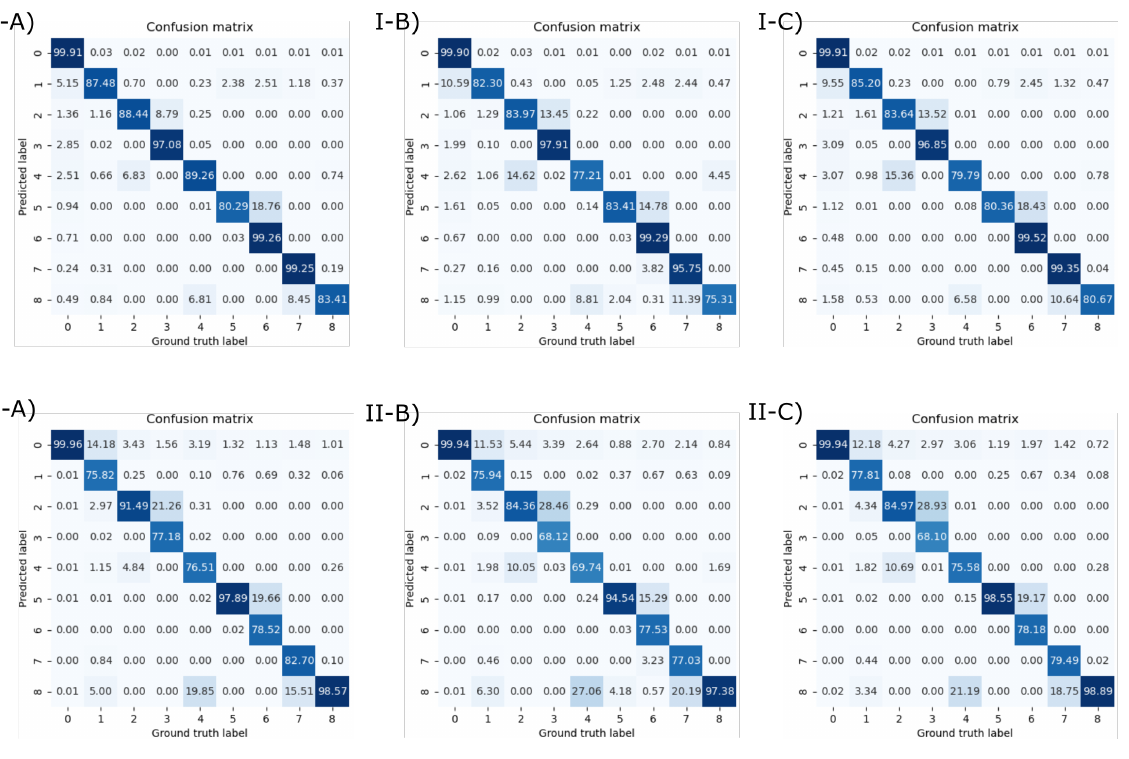
Figure 6. ( Top ) Row-normalized confusion matrices. ( Bottom ) Column-normalized confusion ma- trices. Left: Confusion matrix for the model trained with FDL W . Center: Confusion matrix for the model trained with FDL A . Right: Confusion matrix for the model trained with FDL B